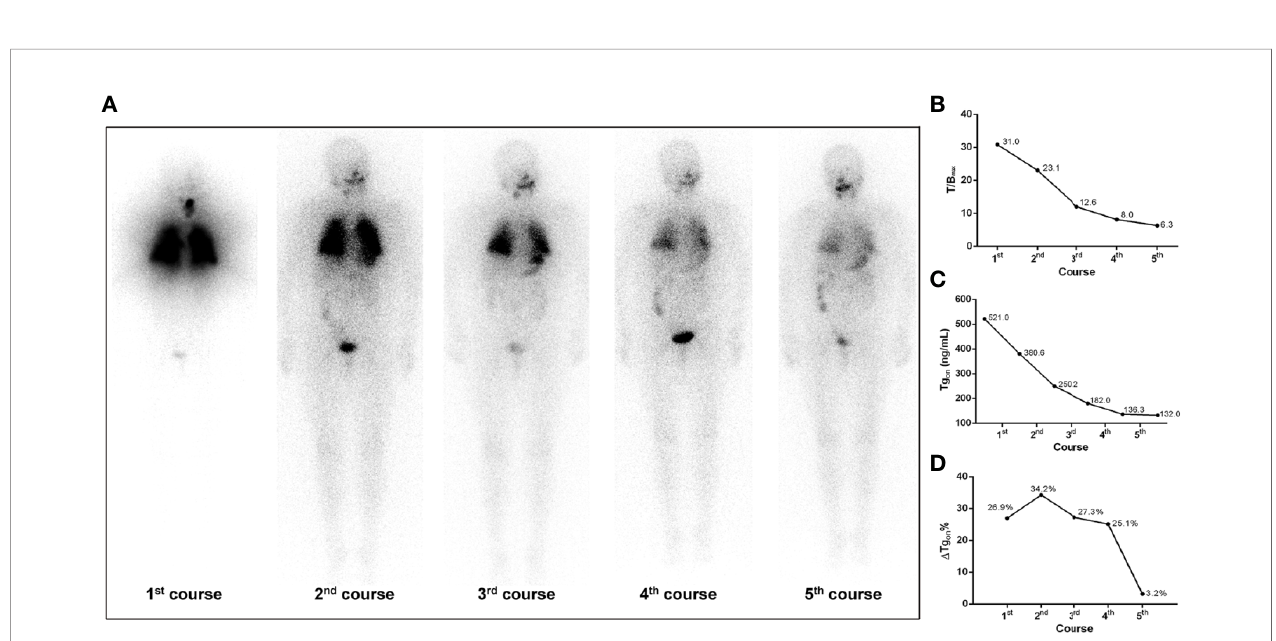
FIGURE 2 | A 68-year-old female differentiated thyroid cancer patient with 131 I-avid pulmonary metastases responding to RT. The T/B max and D Tg on % resulting from the fi rst, second, and third course of RT were more than 8.1 (31.0, 23.1, and 12.6) and 25.3% (26.9%, 34.2%, and 27.3%), respectively, indicating biochemical remission was achievable in the paired latter courses, which were con fi rmed by the signi fi cant decrease in Tg on resulting from the second, third, and fourth course of RT, respectively. After the fourth administration of 131 I, nevertheless, T/B max decreased to 8.0 and D Tg on % declined to 25.1%, indicating a non-effective RT was achievable in the paired latter courses, which was con fi rmed by the subtle decrease in Tg on (3.2%) resulting from the fi fth course of RT. (A) Whole body scans (anterior) at 3 days after the oral administration of 7.4 GBq of 131 I; (B) T/B max ; (C) Tg on ; (D) D Tg on %. RT, radioiodine treatment; T/B max , maximum target-to- background ratio; Tg on , thyroid stimulating hormone-suppressed thyroglobulin; D Tg on %, change rate of Tg on